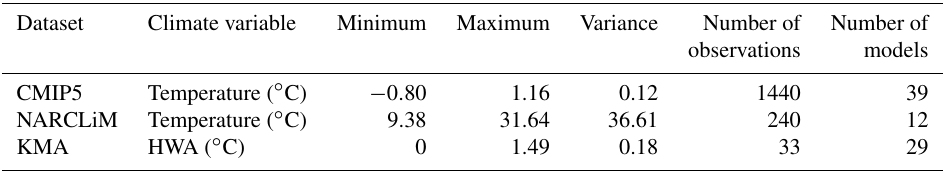
Table 1. Summary of CMIP5, NARCLiM and KMA data properties.